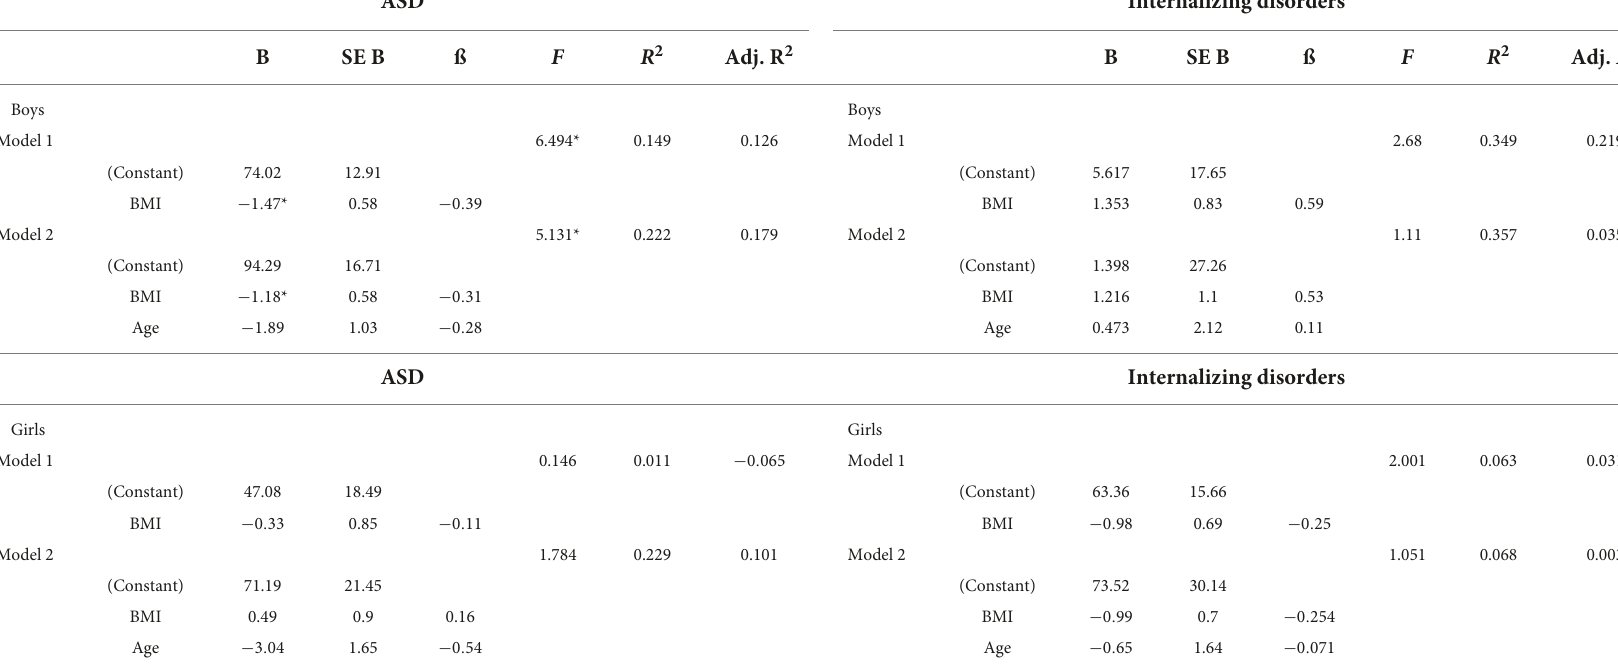
TABLE 4 Results of a linear regression analysis of BMI and Vitamin D3 level for boys and girls and for ASD and internalizing disorders separately.